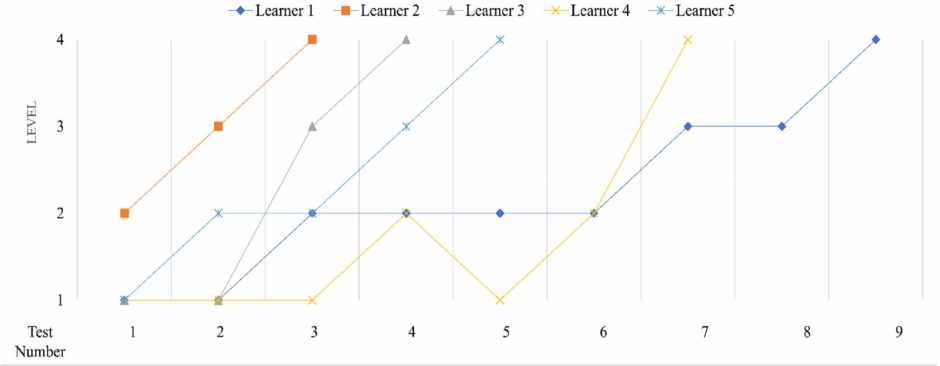
Figure 8. An example of a testing path from five learners in the adaptive formative assessment.